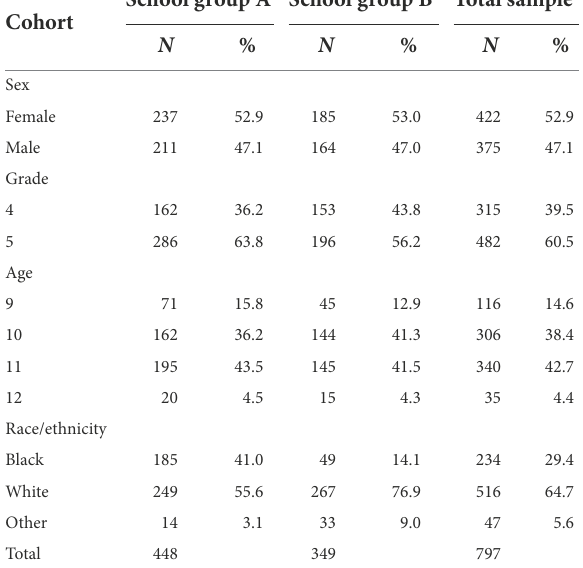
TABLE 1 Demographic characteristics of children in two school